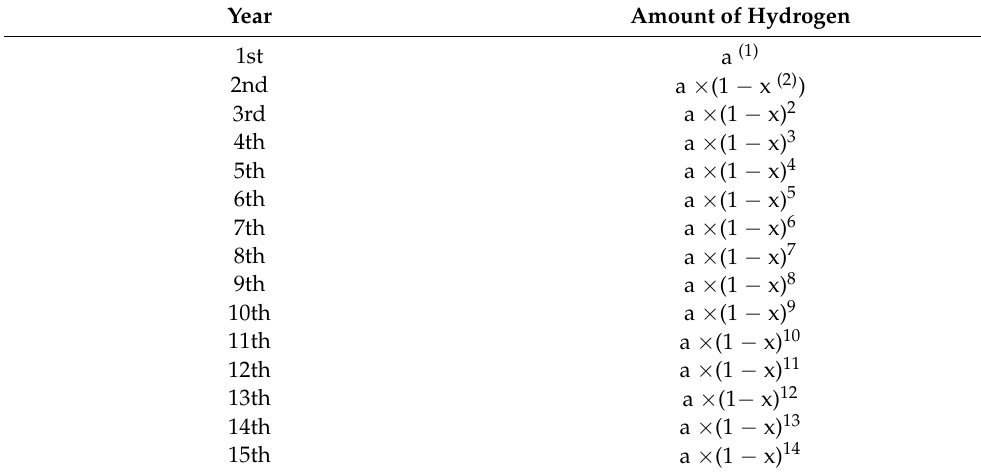
Table 10. Amount of hydrogen produced for the respective